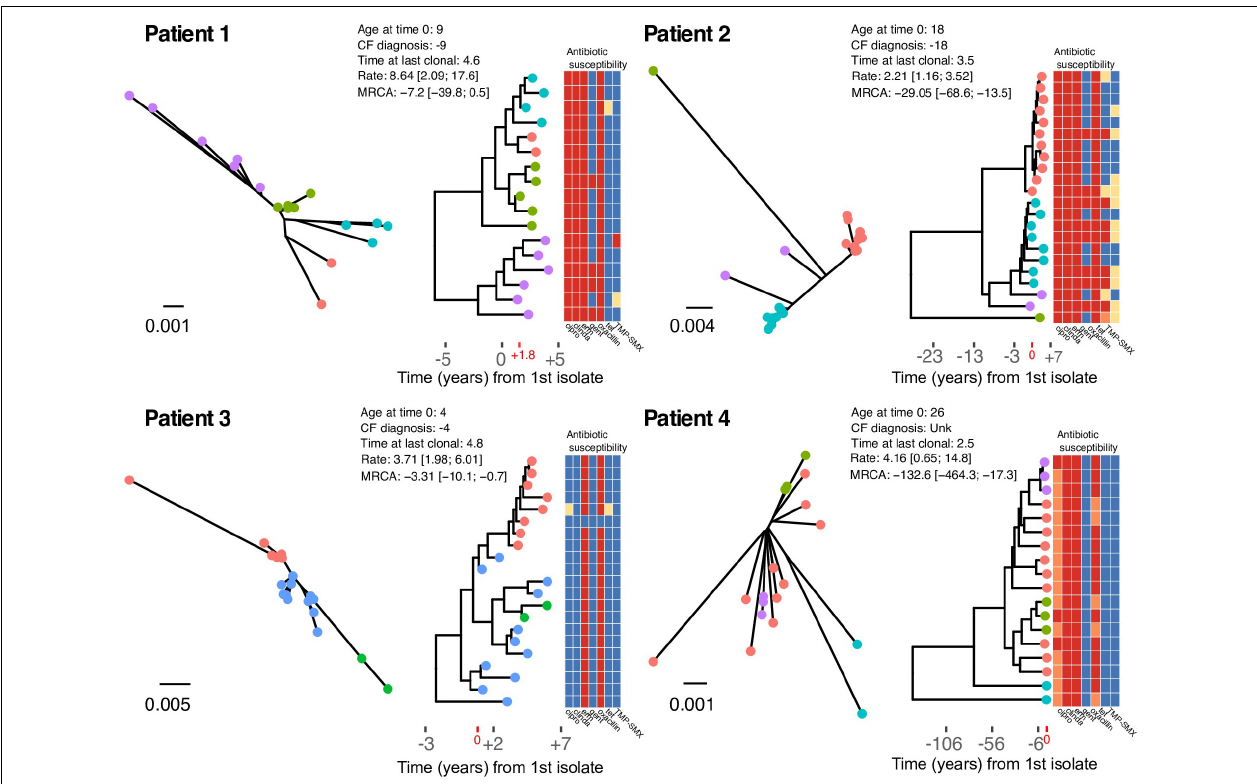
FIGURE 2 | Un-rooted maximum likelihood phylogenies (left), and time-scaled Bayesian coalescent phylogenies with heatmap of phenotypic antibiotic susceptibilities (right) for each patient. Tip labels are colored by sequence cluster as identified by rhierBAPS and illustrate inferred intrahost sub-population structure. Time is scaled as years from the date of the first isolate in our study sample (Year 0), and times are provided for the CF diagnosis, age at time 0, and time at the date of the last clonal isolate (i.e., years of follow-up). Evolutionary rates scaled as SNPs/core-genome/year and estimates of time to the most recent common ancestor (years) are annotated on the phylogeny. The heatmap shows the phenotypic susceptibility results (resistant – red, intermediate – orange, susceptible – blue, and not tested – yellow) for ciprofloxacin (cipro), clindamycin (clinda), erythromycin (erm), gentamicin (gent), oxacillin, tetracycline (tet), and trimethoprim-sulfamethoxazole